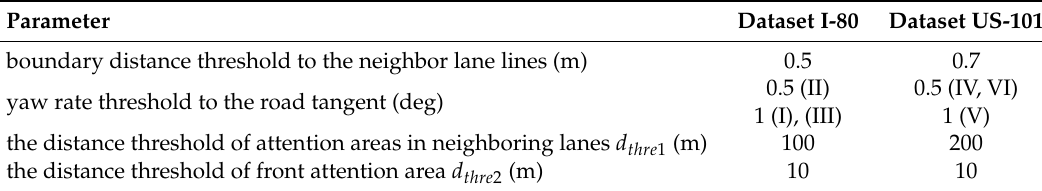
Table 6. Final selected parameters.